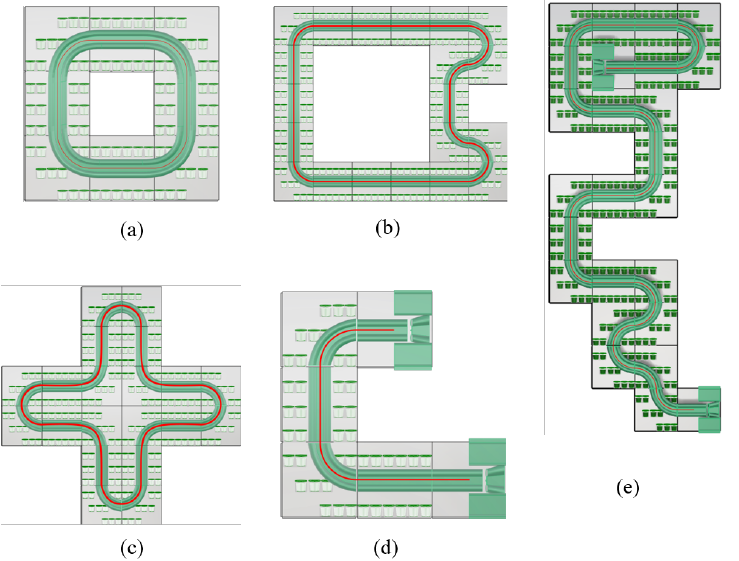
Figure 9. Vertical garden layouts designed considering the introduced guidelines. The track height is 10 cm for all the cases. ( a – c ): closed track designs. ( d , e ): open track designs. It should be noted that the figures are not in the same